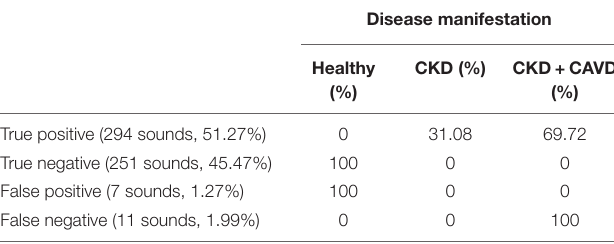
TABLE 3 | Algorithm’s predictive rate.